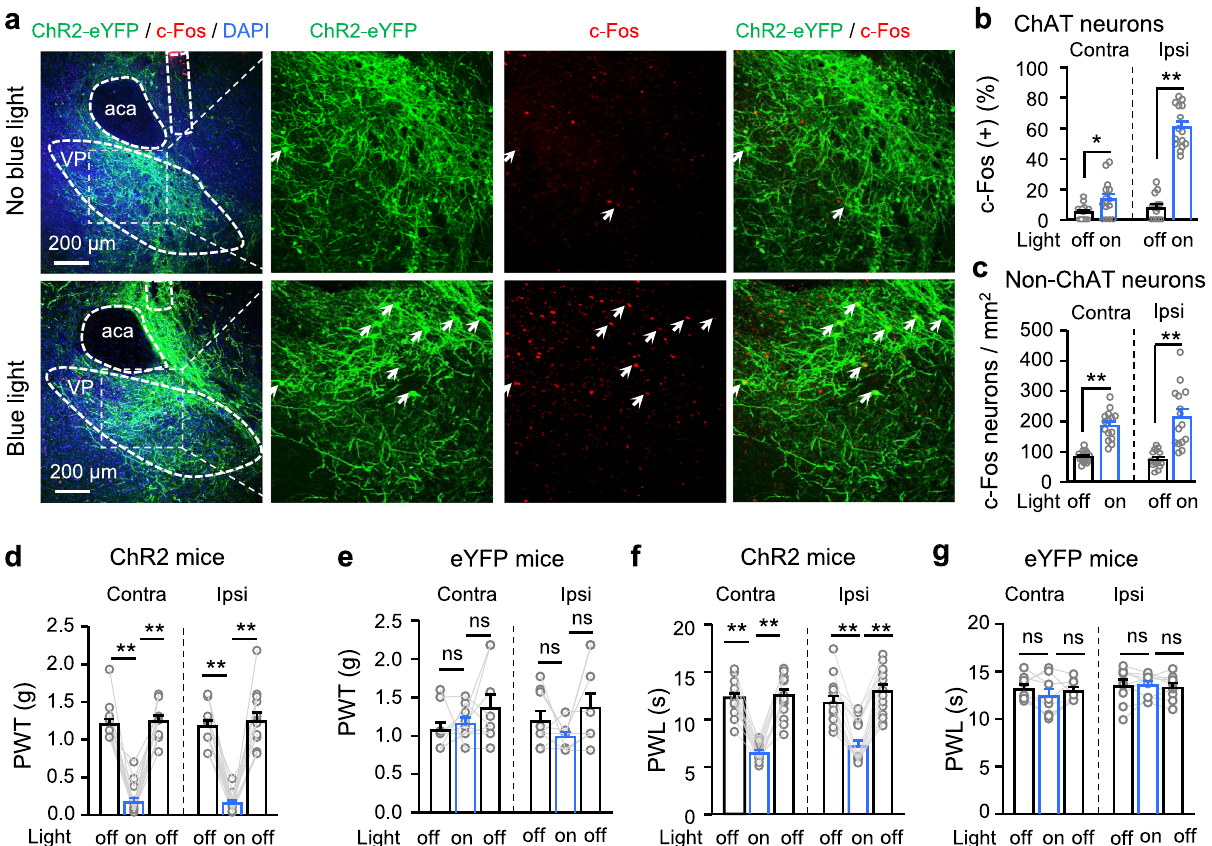
Fig. 4 | Optogenetic stimulation of VP ChAT neurons reduces mechanical and thermalthresholdsandincreasesdepression-likebehaviours.a – c Representative images (ipsilateral side) and summary showing that unilateral optogenetic stimu- lation of VP ChAT (ChAT) neurons increased the number of c-Fos-positive ChAT neurons (red+green) and non-ChAT neurons (red only) in the VP on both sides. b ChAT neurons. Contralateral: t =2.46, df=28, P =0.02. Ipsilateral: t =12.99, df= 28, P <0.0001. c non-ChAT neurons. Contralateral: t =7.61, df=28, P <0.0001. Ipsilateral: t =5.28, df=28, P <0.0001). No light: n =15 sections; light: n =15 sections. All from fi ve mice in each group. d – g Mechanical PWT and thermal paw withdrawal latency (PWL) on hind paws before (off), during (on) (between 1 – 3min light on), and after (off) (10min after light off) illumination of the VP in